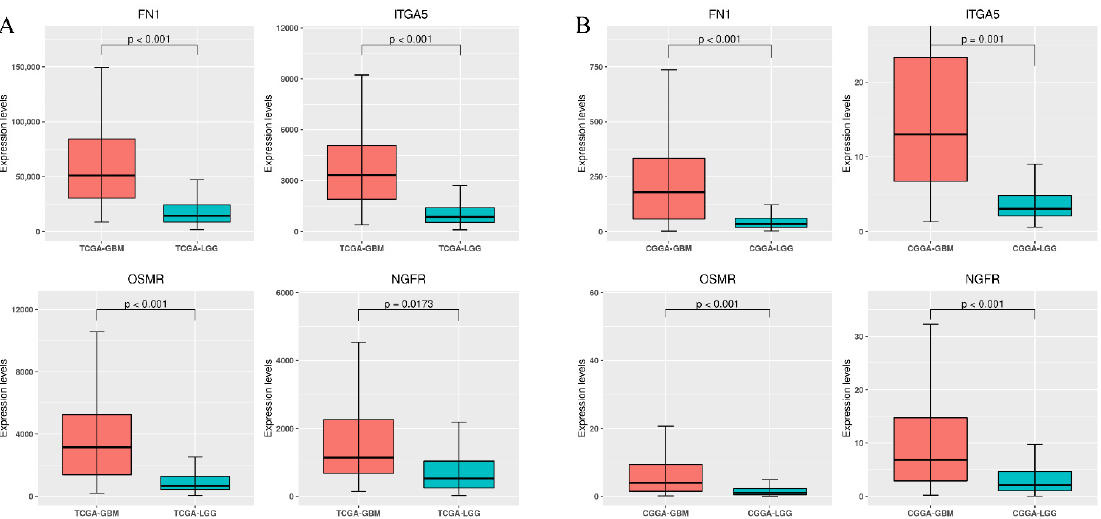
Figure 6. Comparison of gene expression levels between high- and low-grade gliomas for four stiffness-dependent prognostic genes in ( A ) TCGA and ( B ) CGGA. Differences between groups were analyzed using the Student’s t -test.